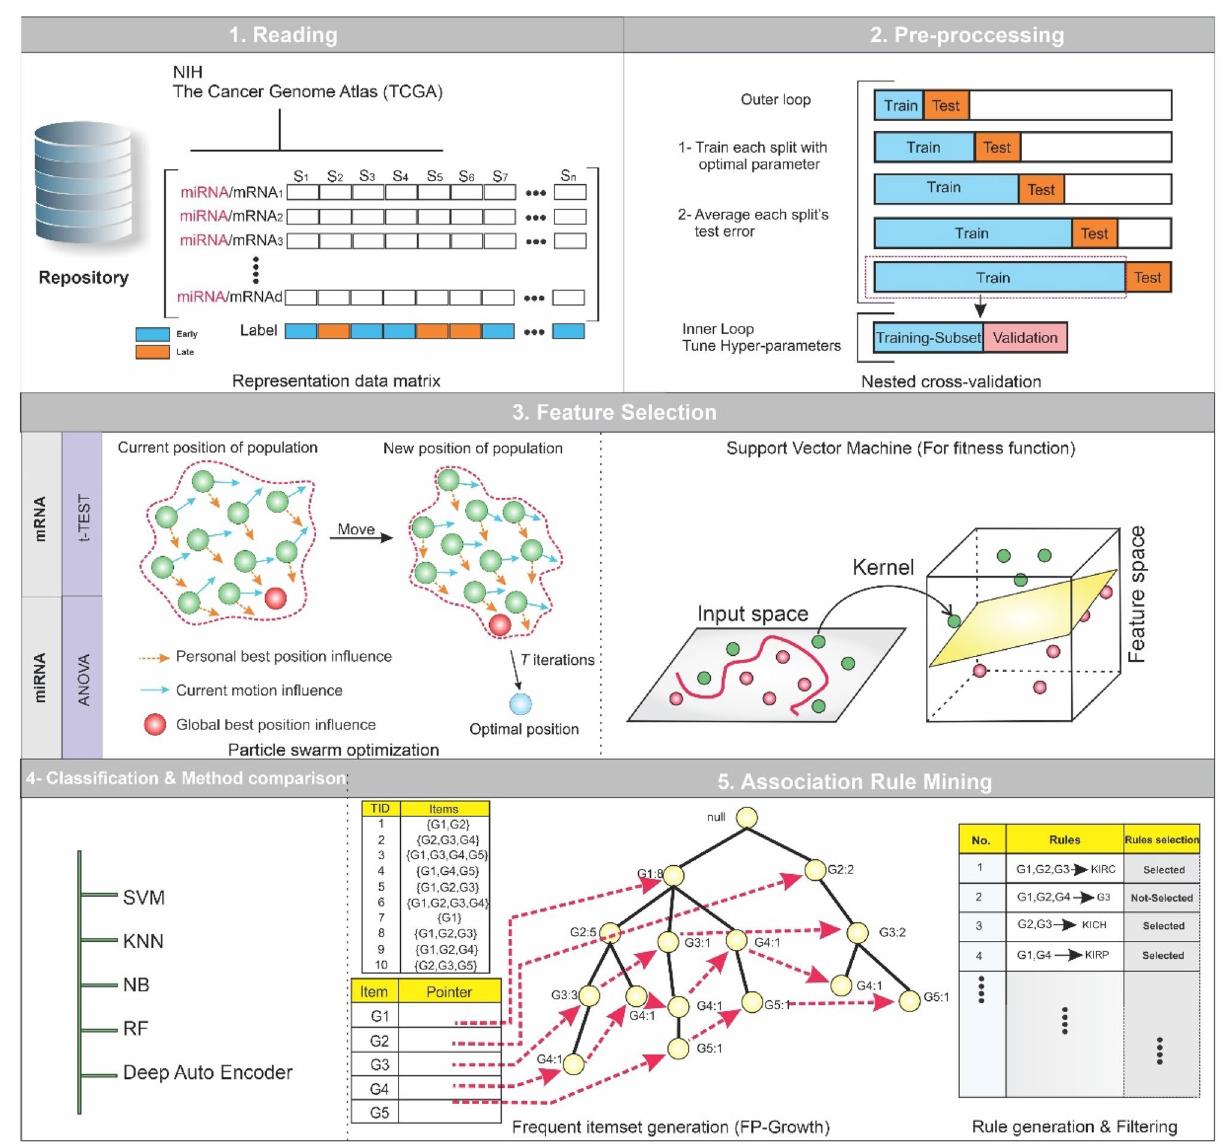
mining. (1) In the reading step, each dataset was downloaded from the TCGA repository. (2) The preprocessing step includes two sub-steps, nested cross-validation, and normalization. (3) The feature selection step contains two sub-steps: the filter method based on t-test for mRNA data and ANOVA for miRNA data, and the wrapper method based on binary particle swarm optimization (PSO) for both mRNA and miRNA data, in which candidate miRNAs/mRNAs with more relevance to early-stage and late-stage Hepatocellular Carcinoma (HCC) were selected. (4) multiclassifier models were utilized to evaluate the discrimination power of selected miRNAs/ mRNAs. (5) The Association Rule Mining method discovered the hidden relationship between selected miRNAs/mRNAs at the early-stage and late-stage of HCC in the first level and the complex relationship among selected miRNAs/mRNAs in the second